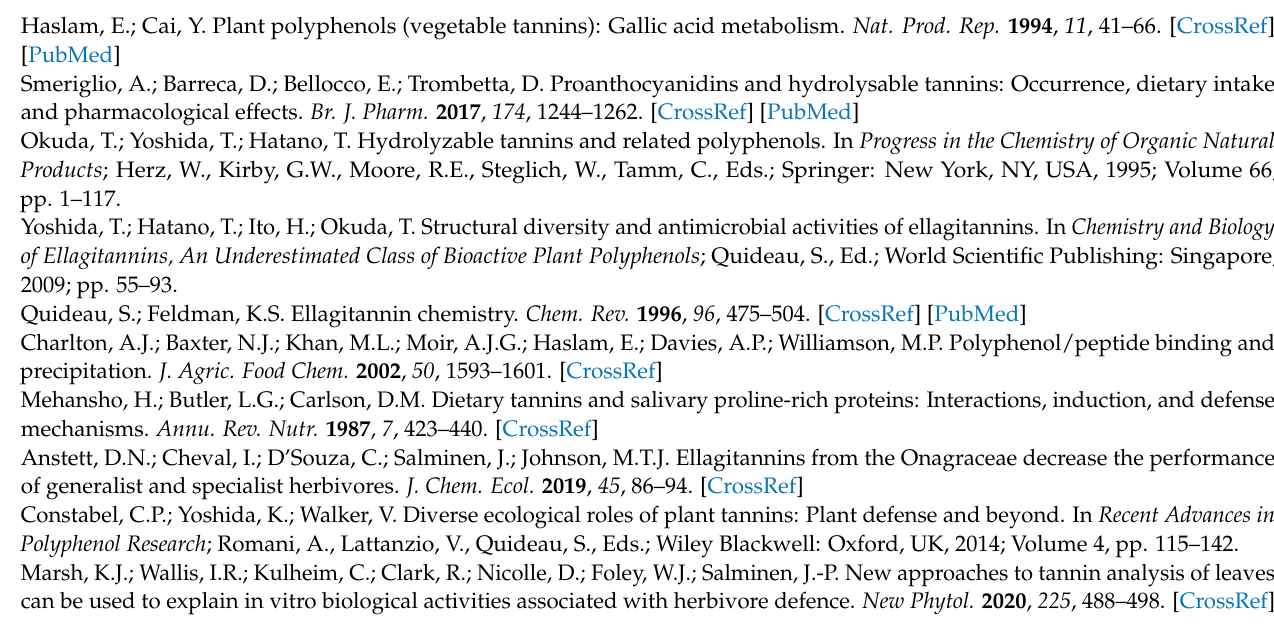
graphic separation, Figure S1: 13 C NMR spectra of polymeric polyphenols obtained from insect tea ( A ) and Platycarya strobilacea ( B ) (DMSO- d 6 , 100 MHz), Figure S2: Thiol degradation of proanthocyani- dins, Figure S3: HPLC of polymeric polyphenols and thiol degradation products, Figure S4: HPLC of acid hydrolysis products of polymeric polyphenols from insect tea ( A ) and polymeric polyphenols from P. strobilacea ( B ), Figure S5: 1 H NMR spectrum of 13 (acetone- d 6 ), Figure S6: 13 C NMR spectrum of 13 (acetone- d 6 ), Figure S7: 1 H– 1 H COSY spectrum of 13 (acetone -d 6 ), Figure S8: HSQC